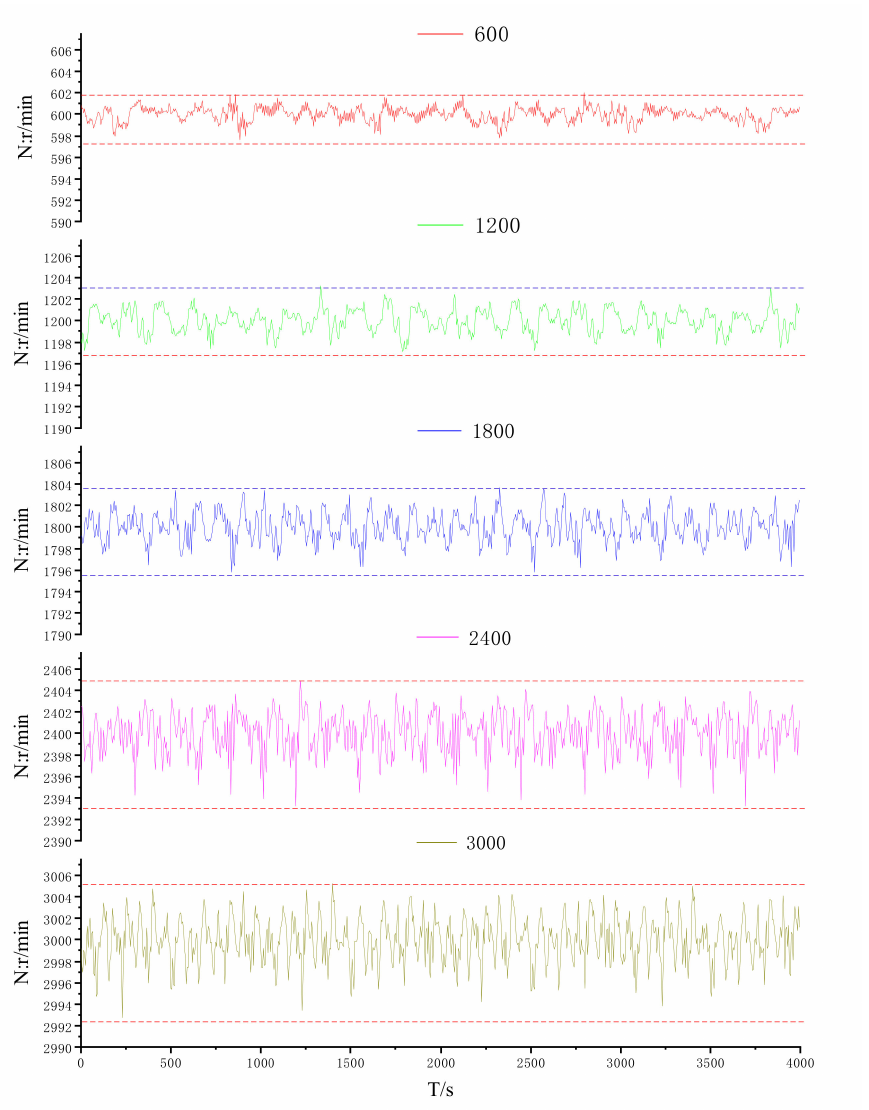
Figure 12. Fluctuation of servo motor speed (constant load/variable